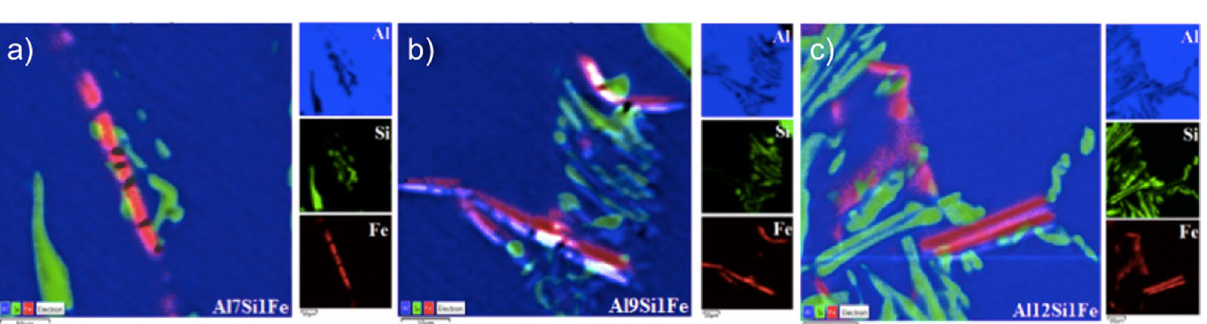
Figure 6. Primary α-Al grain. ( a ) Without the addition and ( b ) with the addition of the Nb + B inoculant (0.05 wt% Nb).